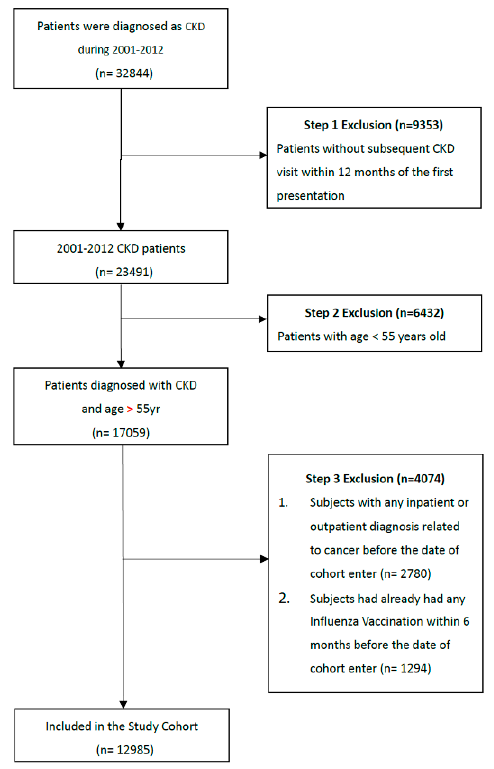
Figure 1. Data selection process. A total of 32,844 patients with CKD diagnoses were enrolled during 2001 to 2012. Patients diagnosed with CKD without subsequent outpatient or inpatient visits, aged less than 55 years, or with pre-existing cancer or a history of influenza vaccination were excluded. A final total of 12,985 patients were enrolled in the